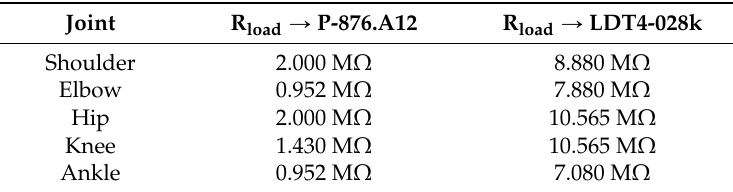
Table 6. The fixed values of the resistors for each